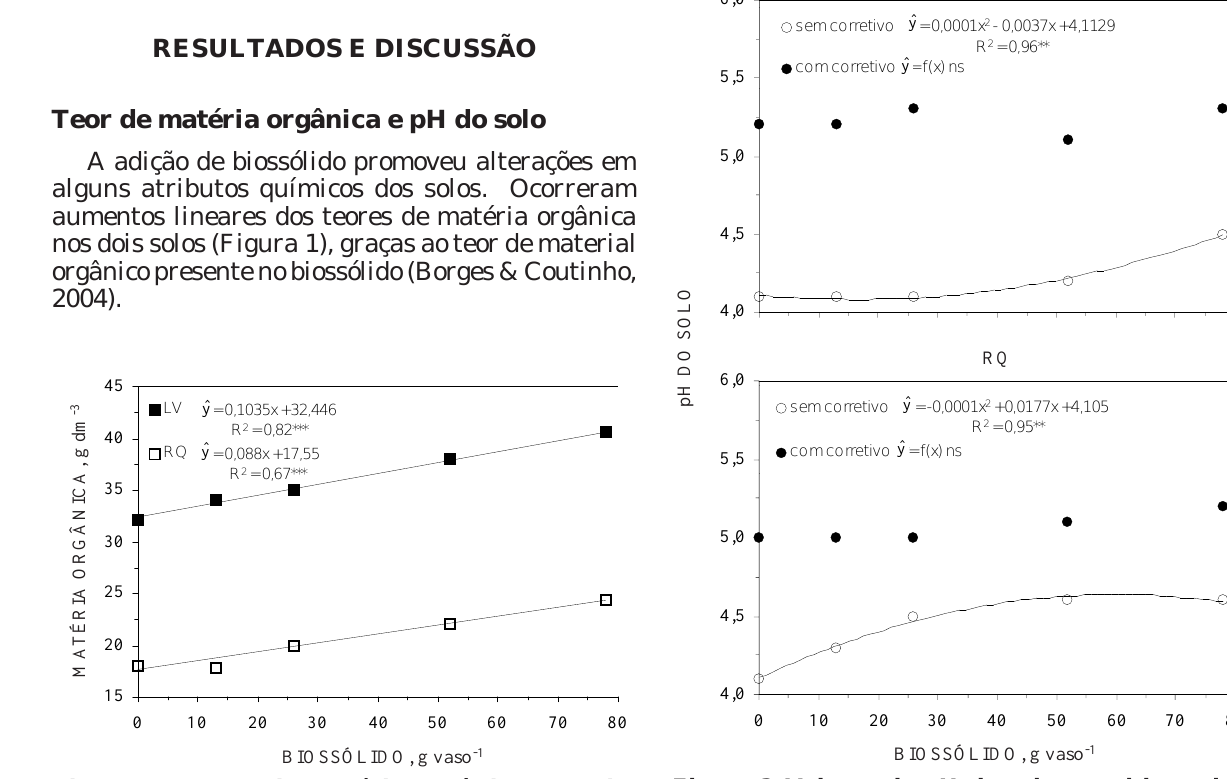
Figura 1. Teores de matéria orgânica no solo, considerando a aplicação de biossólido.